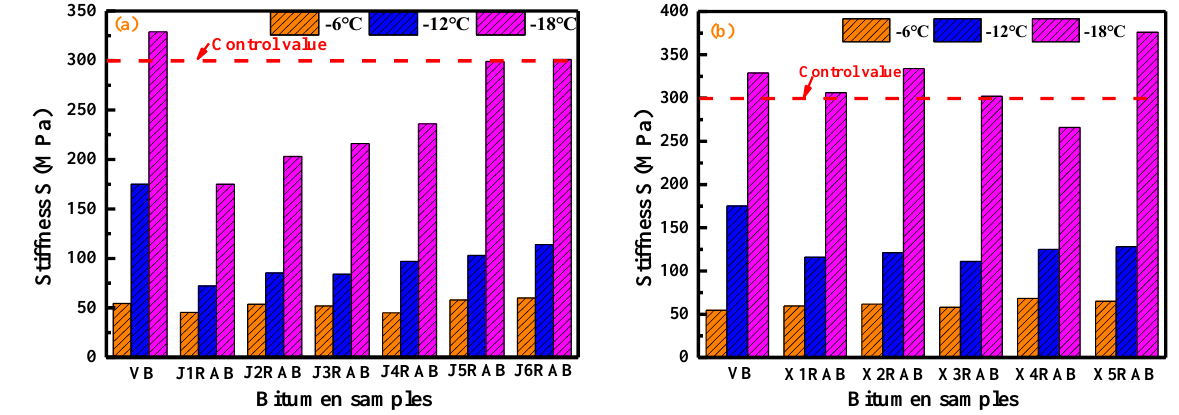
Figure 7. The stiffness values of rejuvenated bitumen at different temperatures.